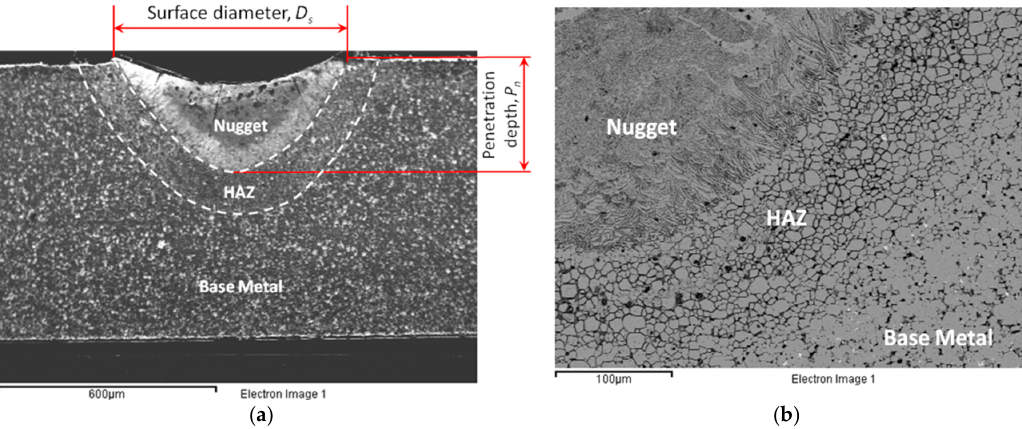
Figure 3. Constitution of a laser spot weld of the sintered NdFeB: ( a ) Definition of characteristic dimensions; ( b ) Three typical regions in a laser weld.